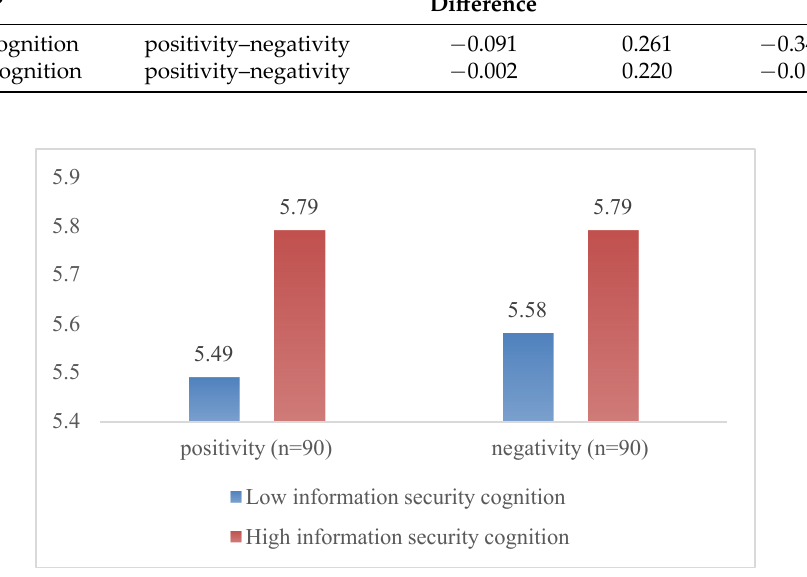
Table 15. Simple Effects (Information Security Cognition and Framework Properties).